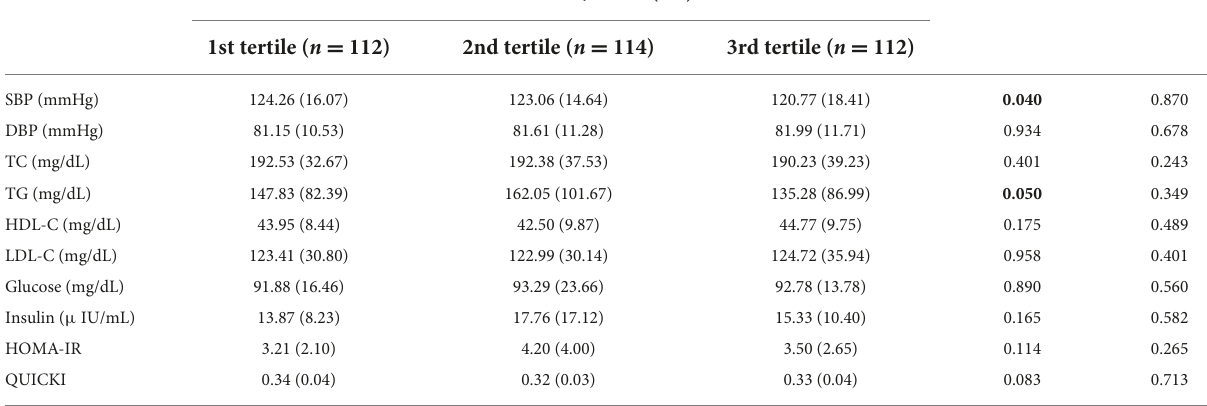
TABLE 2 Cardiometabolic components of participants across different tertiles of LLDS.